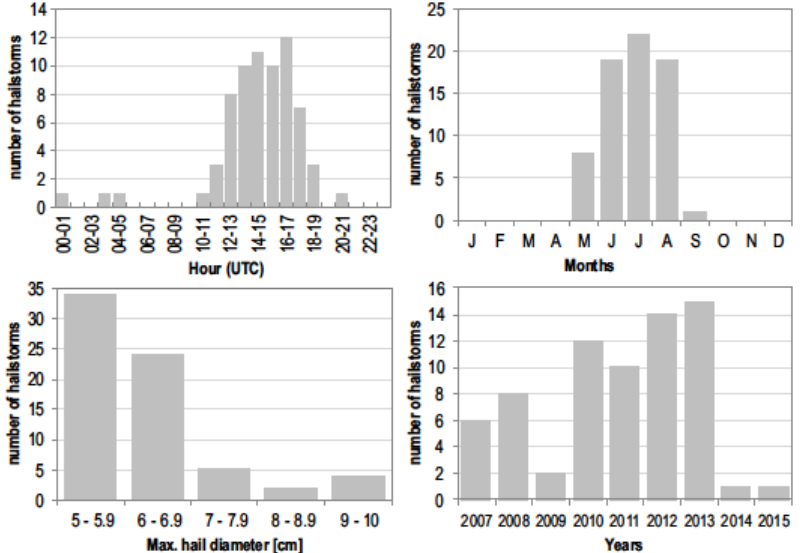
Fig. 3. Large hail distribution in Poland in 2007 – 2015. The colour scale denotes ESWD large hail reports number per 1000 km 2 . Map performed using Kernel density estimation. Source: European Severe Weather